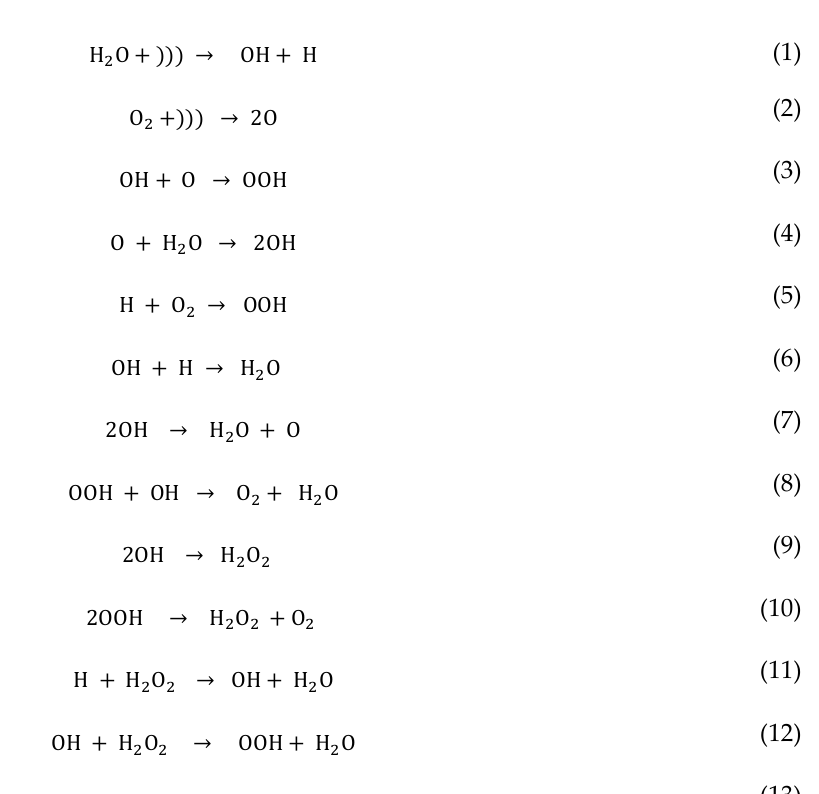
Figure 1. The reaction zone in the cavitation process (adapted from Chowdhury et al.,